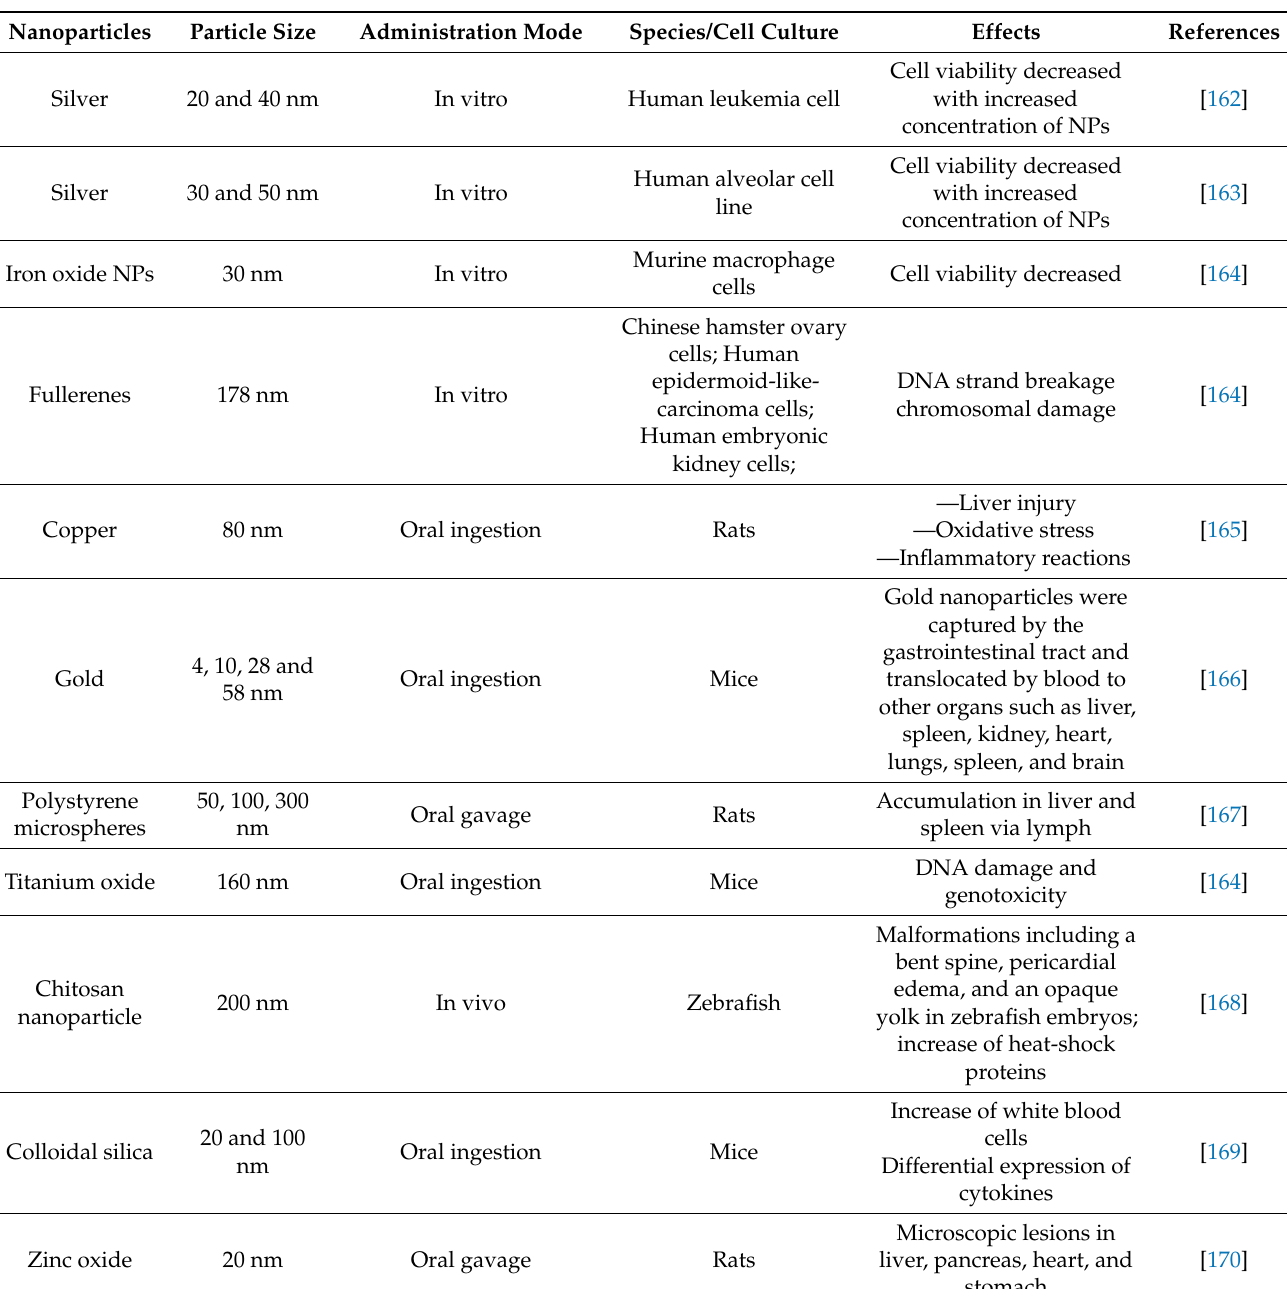
Table 2. A non-exhaustive list of some examples of toxicity of nanoparticles gathered from in vitro and in vivo studies.